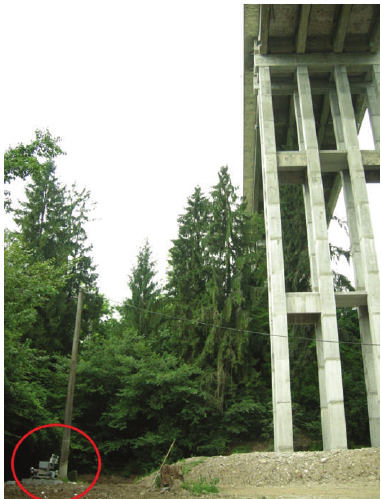
Figure 13: The radar (red circle) placed on a basement under the span.